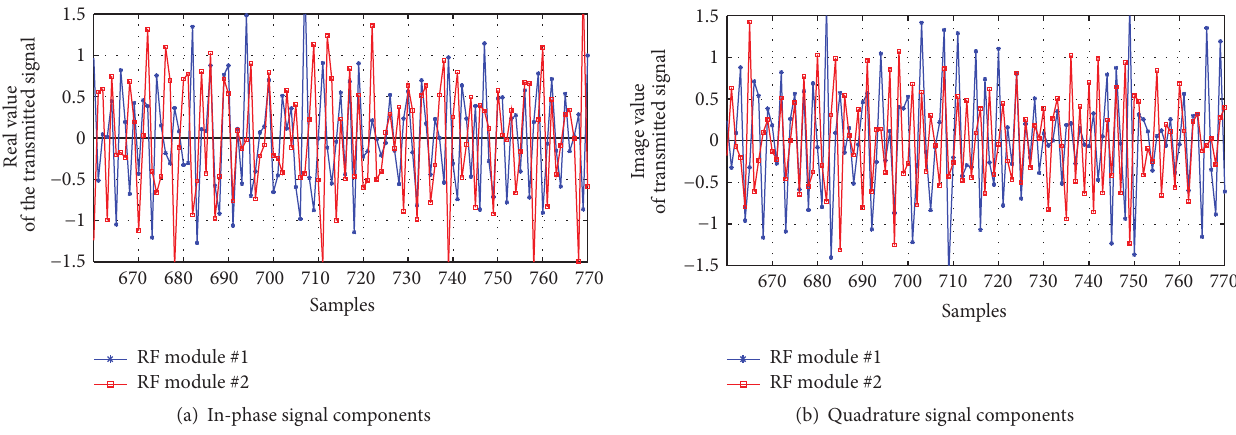
Figure 11: In-phase and quadrature signal components captured before calibration during